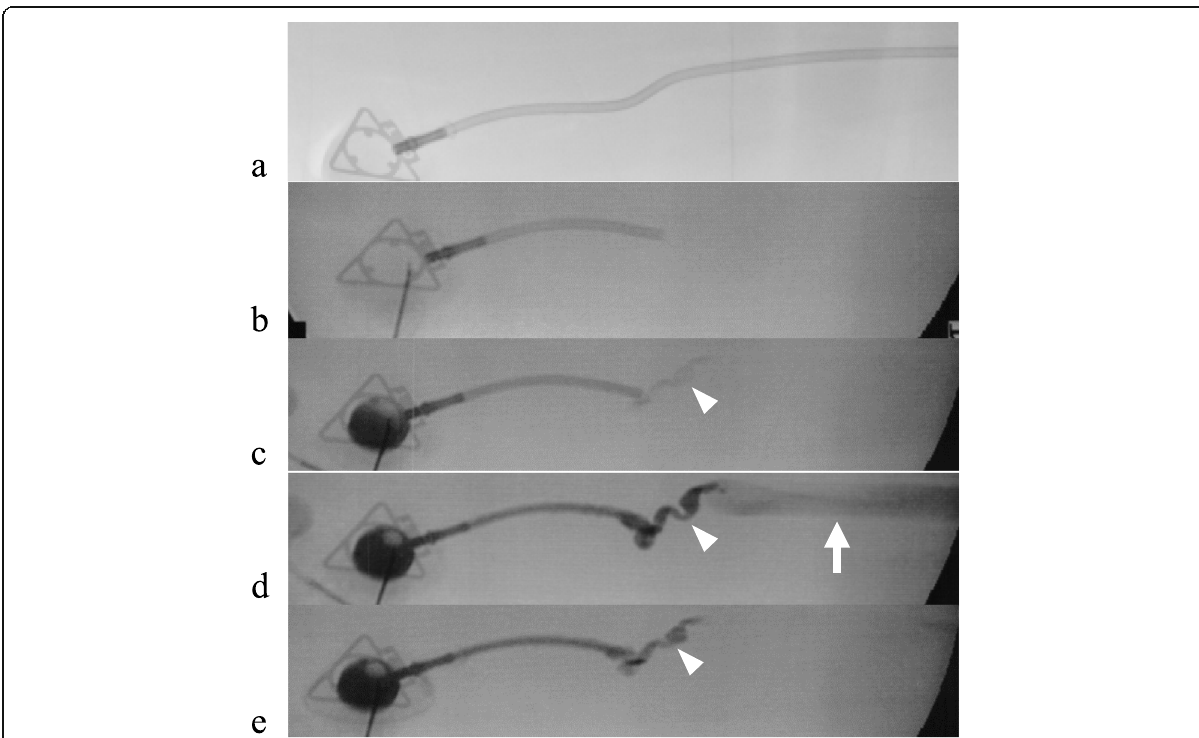
Fig. 2 Contrast injection via totally implantable venous access port (TIVAP) with fractured catheter. a X-ray photography obtained after implantation of TIVAP. b The fractured catheter was spontaneously found 7 months after implantation of TIVAP. c , d , e Saline was injected upon removal of the TIVAP septum; back flow from the TIVAP septum was slightly bloody. When contrast-enhanced sodium was injected through the TIVAP septum, contrast flow was observed in the femoral vein (arrow). A narrow tract can be seen between the tip of the fractured catheter and the femoral vein (arrowhead)